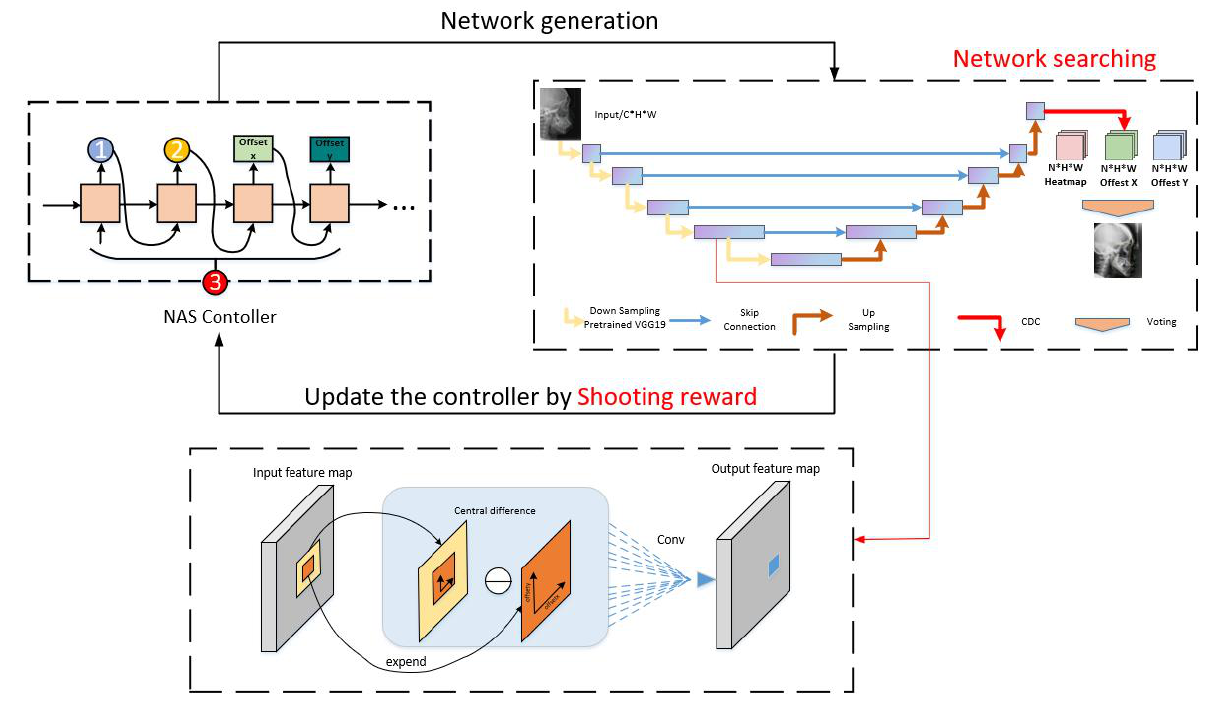
Figure 2. The overall framework of our method. We design a reward (shooting reward) and exploit a neural architecture search algorithm (reinforcement learning-based with LSTM controller) beyond a search